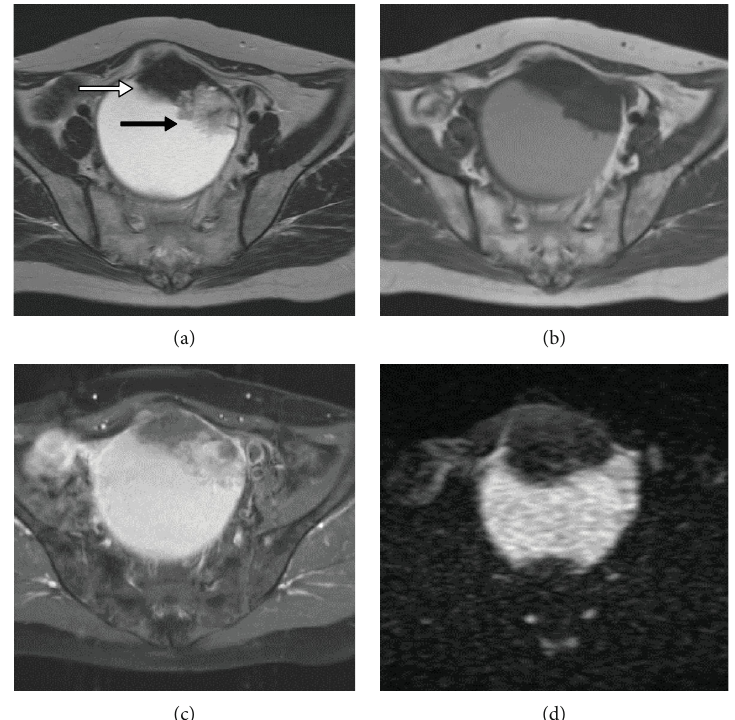
Figure 1: MR fi ndings for the borderline Brenner tumor in a 54-year-old woman. (a) The axial T2WI shows a unilocular cystic tumor in the pelvic cavity which was 9 cm in diameter with two solid components. The cystic content has the same signal intensity (SI) as water. The solid mass located at the anterior wall (white arrow) shows low SI similar to the SI of muscle. The papillary tumor on the left side of the solid mass (black arrow) shows an intermediate SI, slightly higher than the SI of muscle. (b) The axial T1WI shows the cystic content has slightly higher SI than water. The solid mass shows slightly lower SI than muscle. The papillary tumor on the left side of the solid mass shows low SI, similar to the SI for muscle. (c) Gadolinium-enhanced fat-saturated T1WI shows the solid mass is slightly enhanced and the papillary tumor is well enhanced. (d) Axial DWI ( b = 0 , 1000 s/mm 2 ) shows a solid mass with a low SI and the papillary tumor with high (Figure 1). The ADC value for the solid mass obtained from DWI ( b = 0 , 1000 s/mm 2 ) was 0 : 51 × 10 − 3 mm 2 /s , whereas that for the papillary tumor was 1 : 10 × 10 − 3 mm 2 /s .